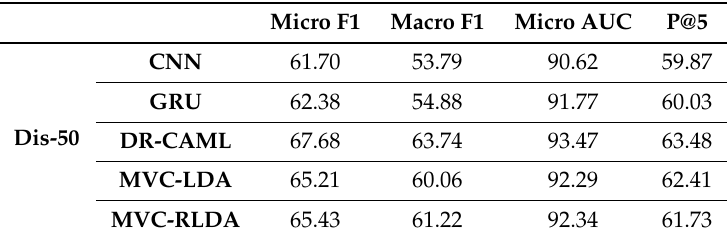
Table 6. Results of hierarchical models obtained on the MIMIC-III Dis-50 dataset.